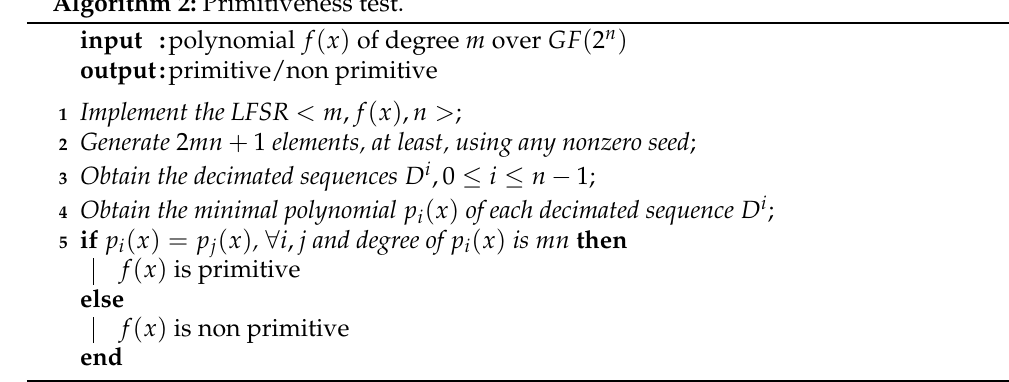
Algorithm 2: Primitiveness